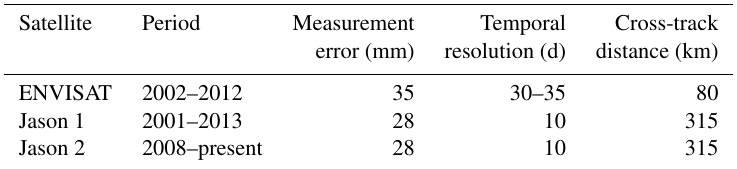
Table 1. Summary of the satellite altimetry data used in this study. Periods of availability, measurement errors, temporal resolutions, and cross-track distances are